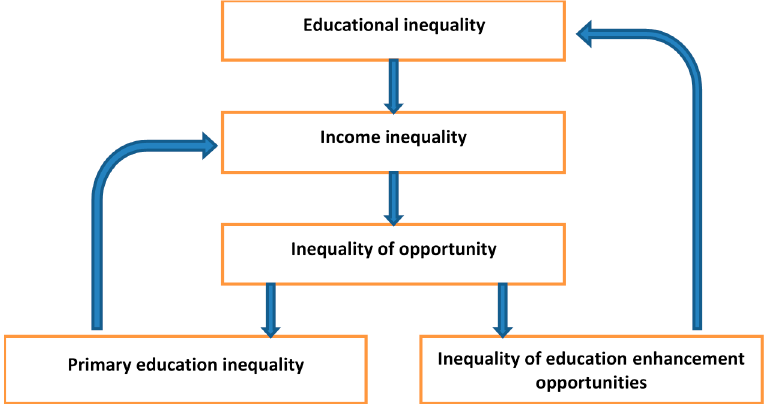
Figure 1. Vicious cycle of educational inequality. Source: Own results.